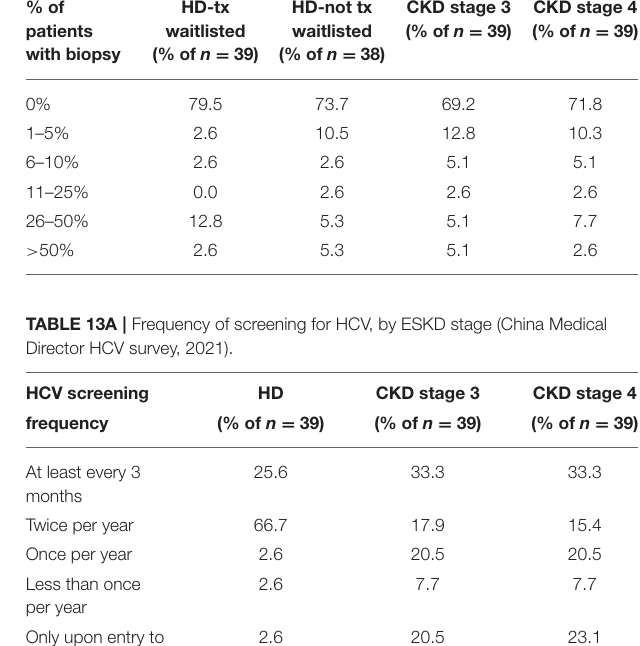
TABLE 12 | Estimated percent of facility HCV + patients who have ever had a liver biopsy, by ESKD stage (China Medical Director HCV survey, 2021). % of patients with biopsy